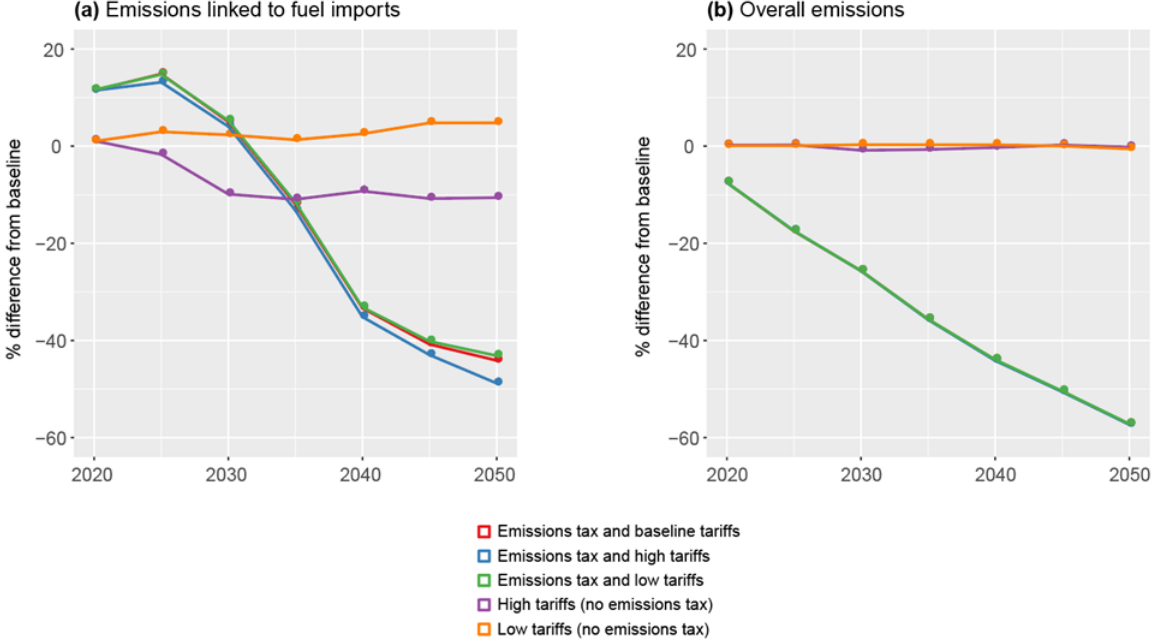
Figure 6. Changes from the baseline scenario for the global level. The figure is in terms of emissions associated with fuel imports ( a ) and overall ( b ). Each line is colored by a different scenario.